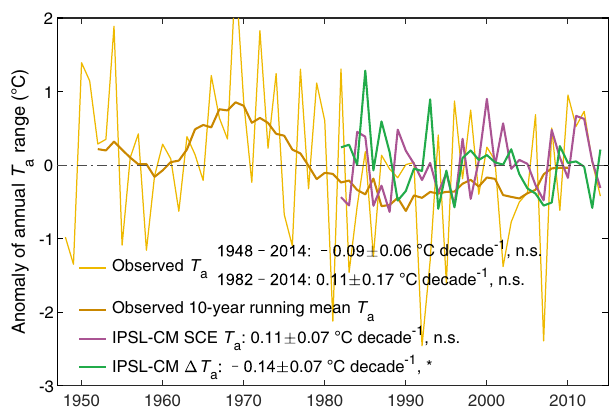
Fig. 3 Vegetation-induced changes in the annual temperature range. Anomalies of observed (brown, from the Princeton Global Meteorological Forcing product) and IPSL-CM-simulated (purple, from the dynamic vegetation experiment SCE) annual ranges of Northern Hemisphere (NH) land mean air temperature ( T a ). The bold brown curve indicates the 10-year running mean of the observed annual T a range. The green curve indicates the simulated annual T a range induced by leaf area index (LAI) changes in all growing seasons combined. * p < 0.1; n.s., p >